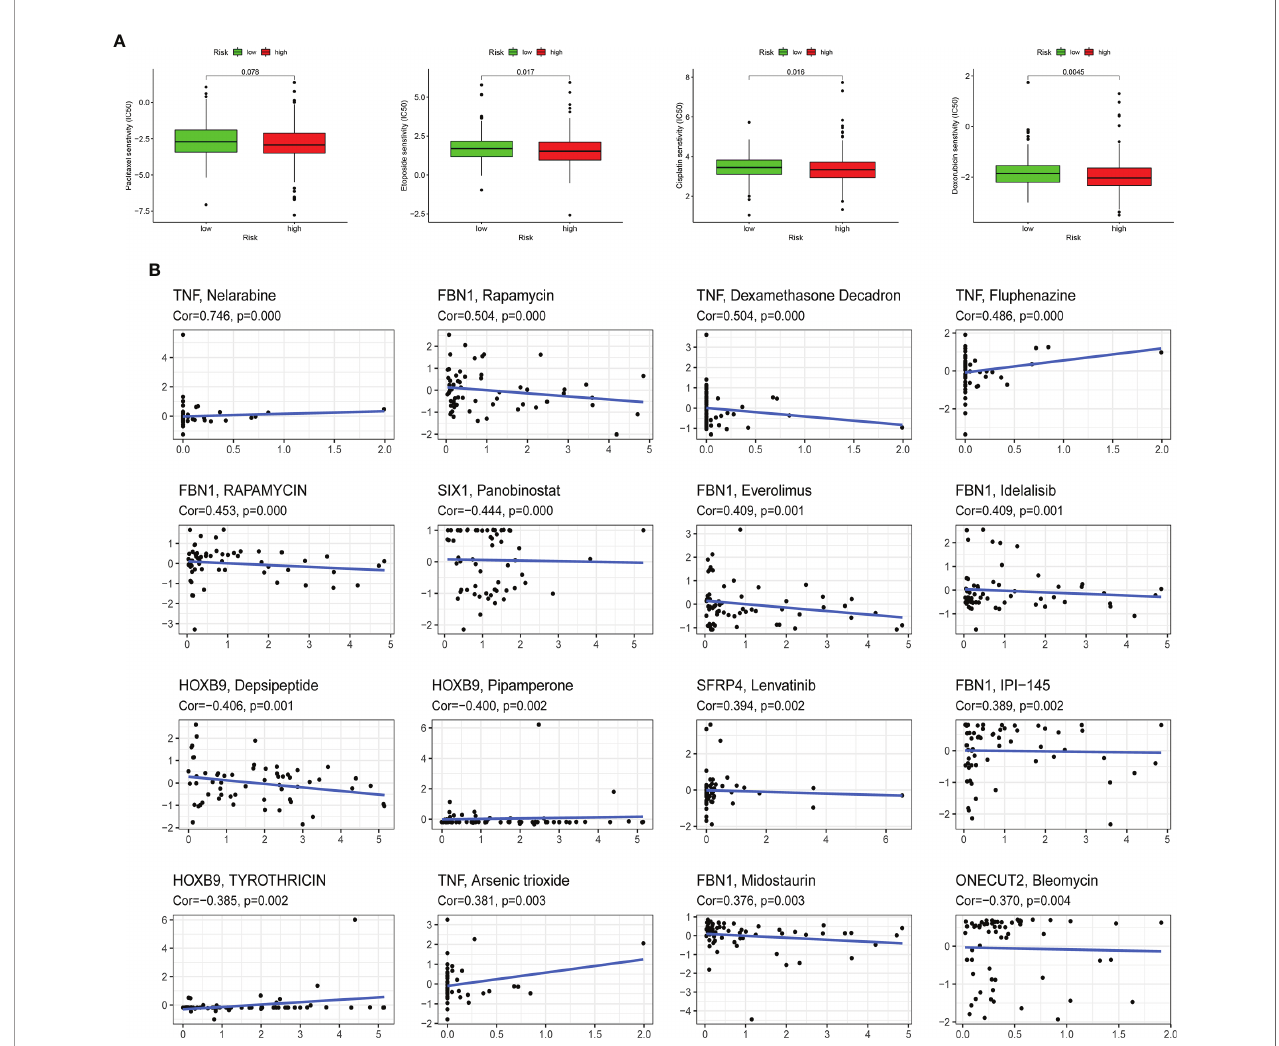
FIGURE 8 | Association between the risk score, ERGs, and chemosensitivity in EC. (A) The box plots of the estimated IC50 for paclitaxel, etoposide, cisplatin, and doxorubicin in high-risk and low-risk groups. (B) Scatter plot of the relationship between the expression of ERGs and drug sensitivity. EMT, epithelial – mesenchymal transition; ERG, EMT-related gene; EC, endometrial